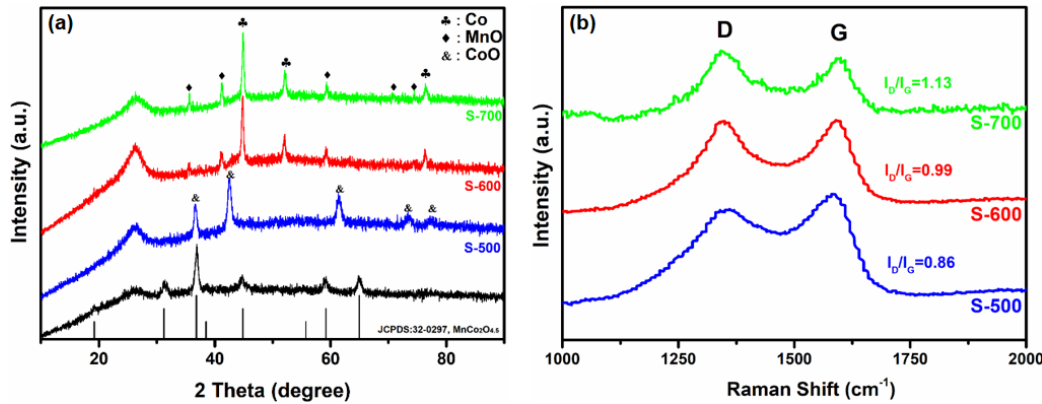
Figure 2. ( a ) XRD patterns of the pristine MnCo 2 O 4.5 , S-500, S-600, and S-700; ( b ) Raman scattering spectra of S-500, S-600, and S-700.